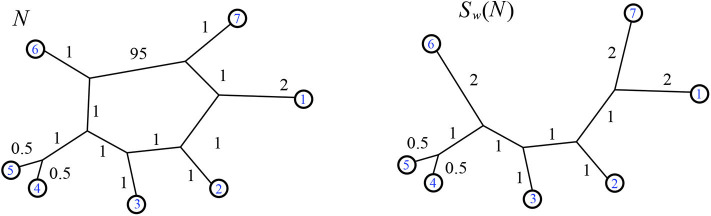
Example of the action of Sw. HeredN=(4,5,6.5,6.5,7,4,3,4.5,4.5,5,4,3.5,3.5,4,5,1,3.5,6.5,3.5,6.5,7).